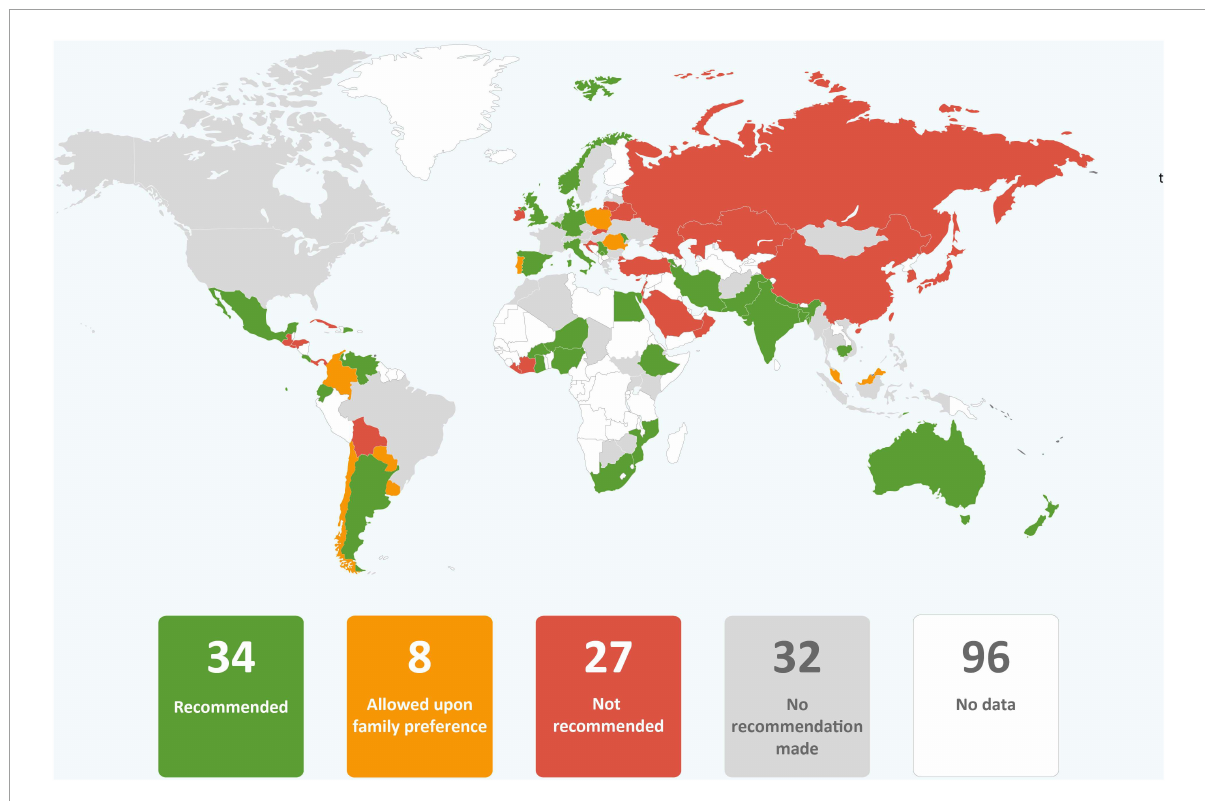
FIGURE2 Global distribution of recommendations on skin-to-skin contact for infants of mothers with COVID-19 (data from 101 countries).